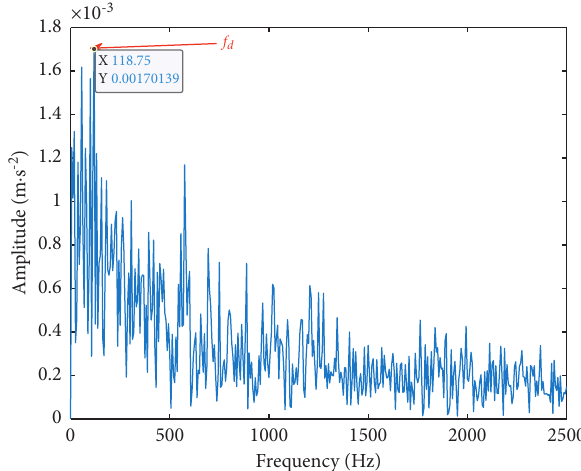
Figure 15: Envelop analysis of the reconstructed signal only using the selected